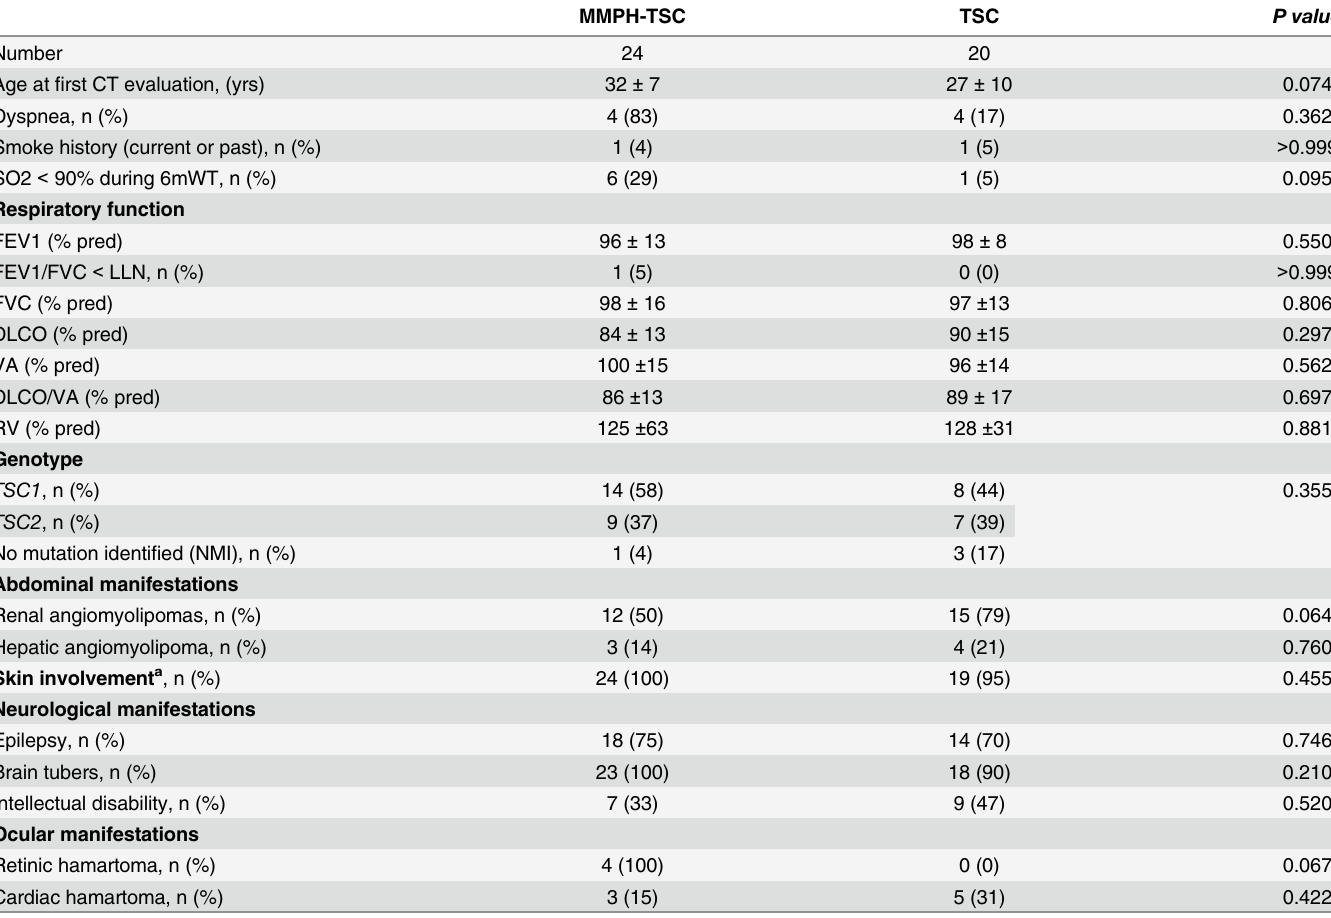
Table 3. Demographic, pulmonary, clinical characteristic and genetic analysis of TSC patients according with